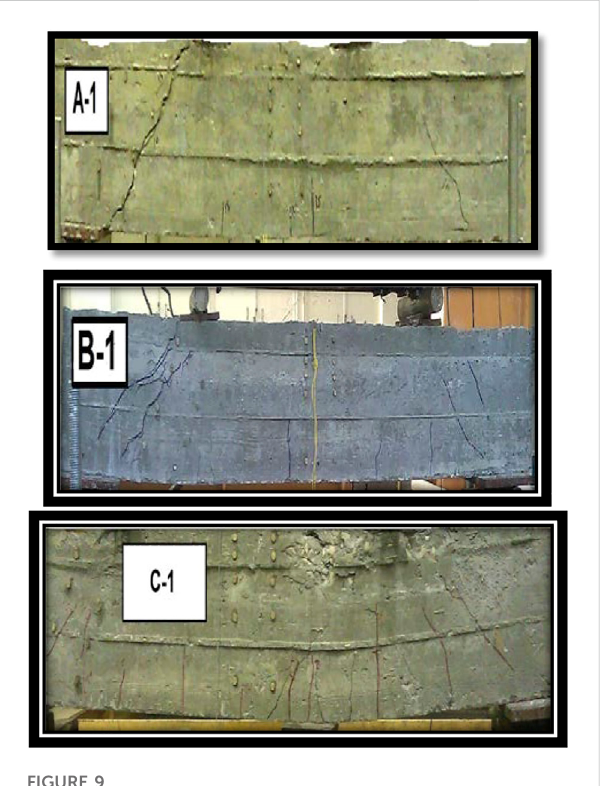
FIGURE 10 Propagation of cracks and modes of failure for HSFRC beams with a v f of 0.5% and varying a/d ratios.